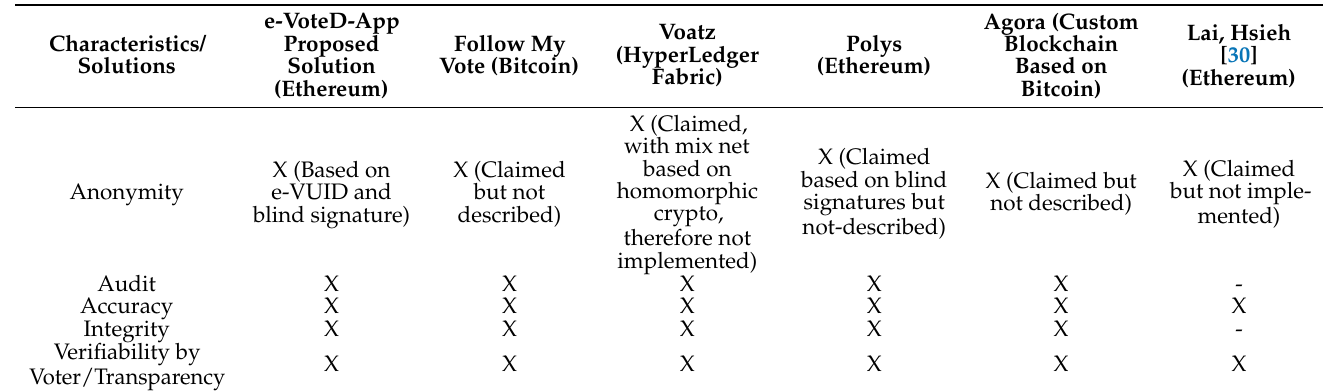
Table 3. e-Voting Solutions Comparison based on